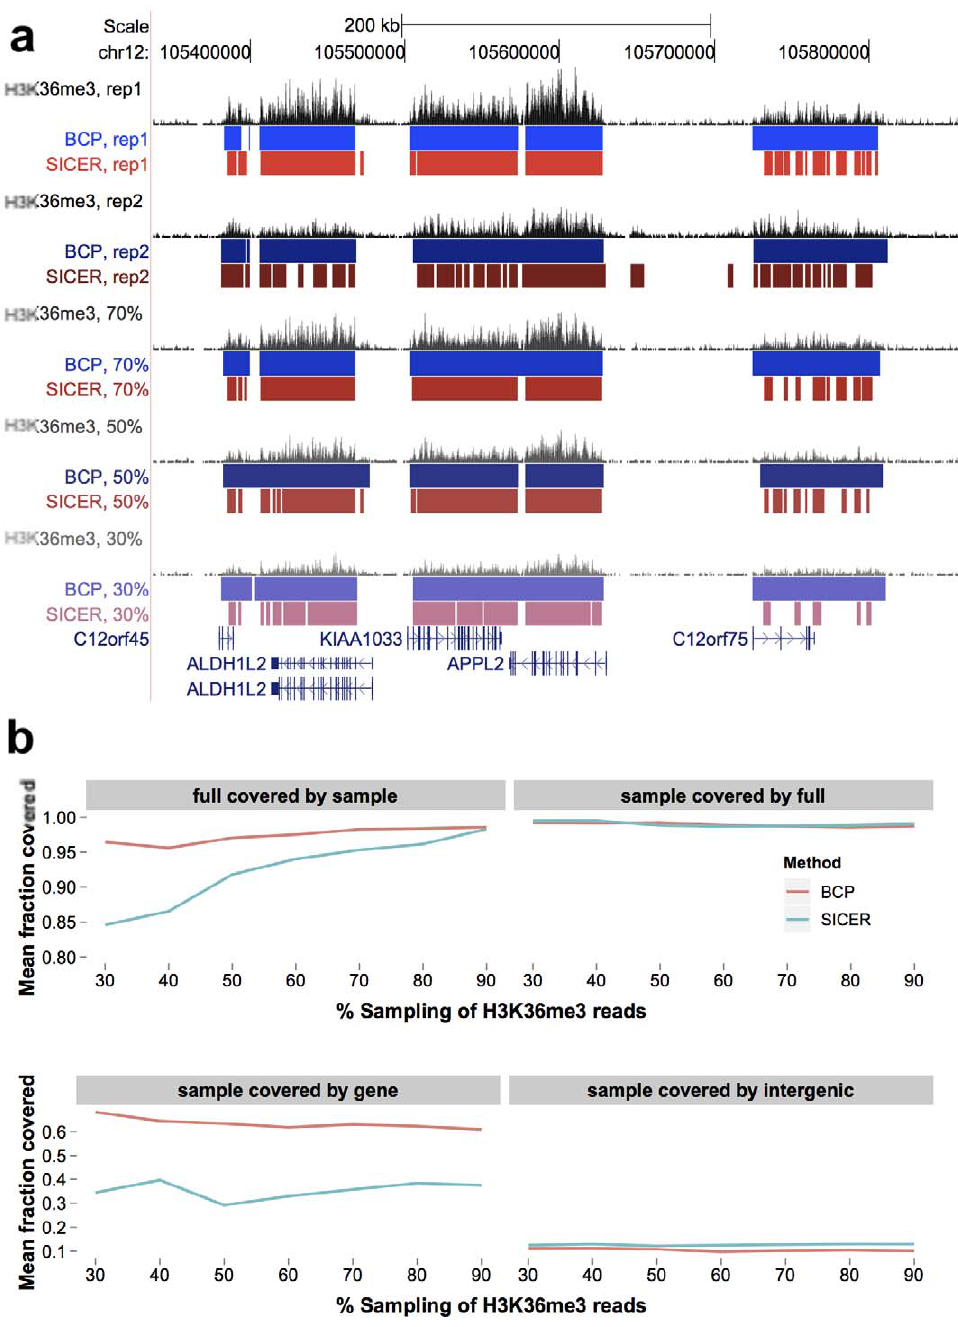
Figure 3. BCP was robust, providing consistent results in replicate and at various coverage depths. Using a second H3K36me3 data set and sub-samplings of the full replicate one dataset (30–90% randomly selected reads), we evaluated the reproducibility of BCP island calls. A) Enriched regions coinciding with gene coordinates were captured by the large, contiguous BCP islands (blue), while SICER islands (red) were more fractionated. B) We quantified the reproducible fraction of the full data set results versus the sub-samples (the number of full dataset island bases covered by a replicate/sub-sample island divided by total bases in full dataset islands, averaged across all islands) and vice versa. Also, we computed the fraction of island basepairs overlapping genic and intergenic regions (number of islands bases covered by genic/intergenic annotation divided by total bases in island, average across all islands).